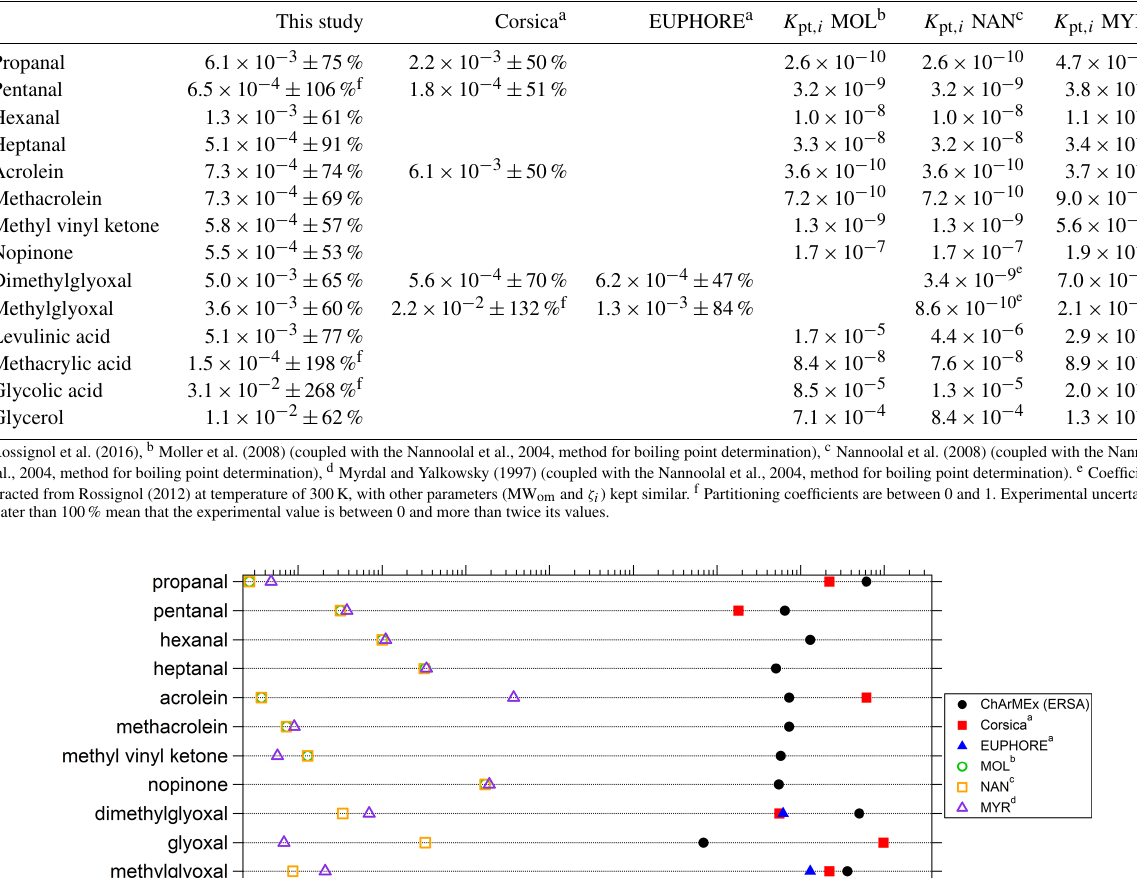
Table 2. Experimental (averaged over the campaign, with ± XX% representing the 1 σ standard deviation over the campaign) and theoretical partitioning coefficients determined for this study and compared to previous field and chamber campaigns.